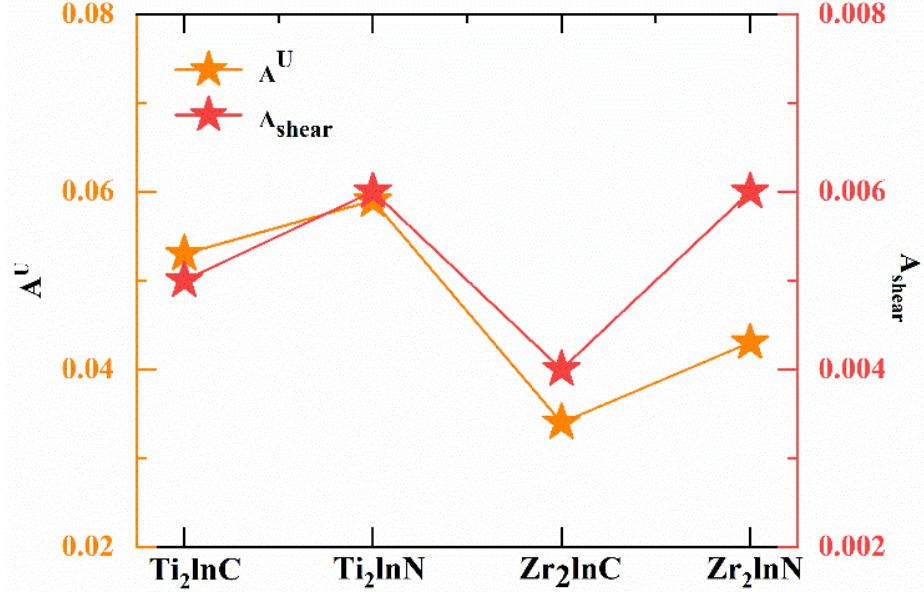
Figure 5. Variations of A U and A shear of M 2 InX (M = Ti, Zr and X = C, N) MAX phases.